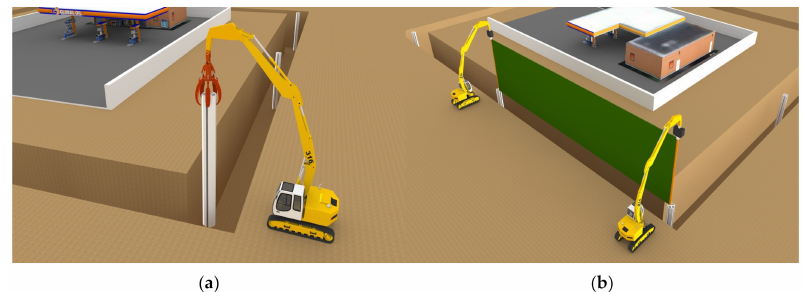
Figure 6. Installation of ( a ) the supporting pile and ( b ) the smart liner.